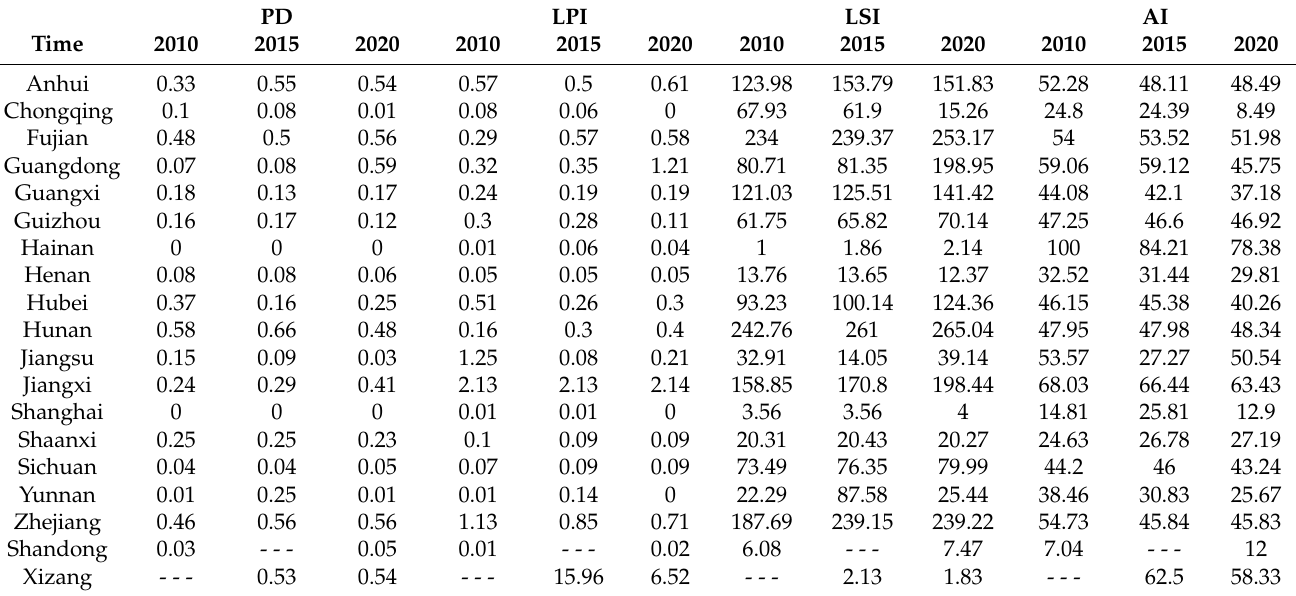
Table 4. Changes in PD, LPI, LSI, and AI indices of moso bamboo forests in each province. PD LPI LSI